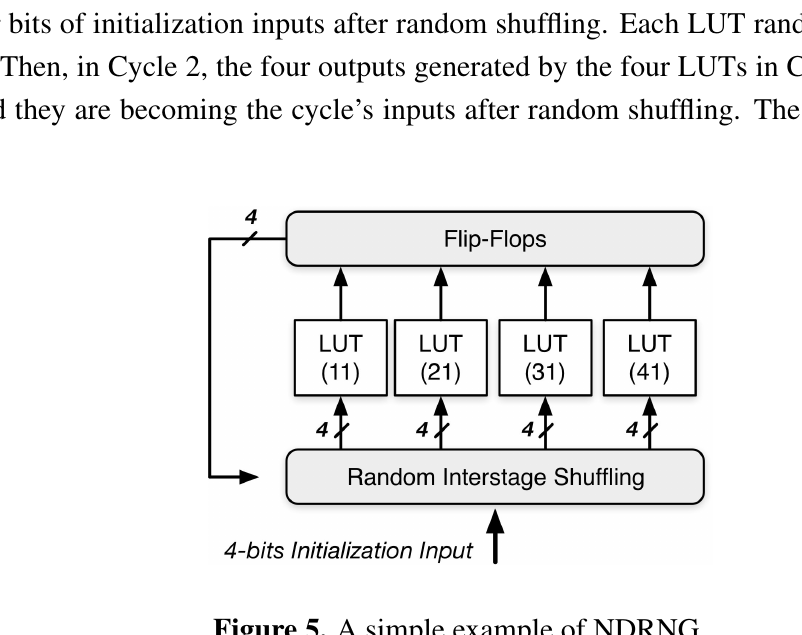
Figure 5. A simple example of